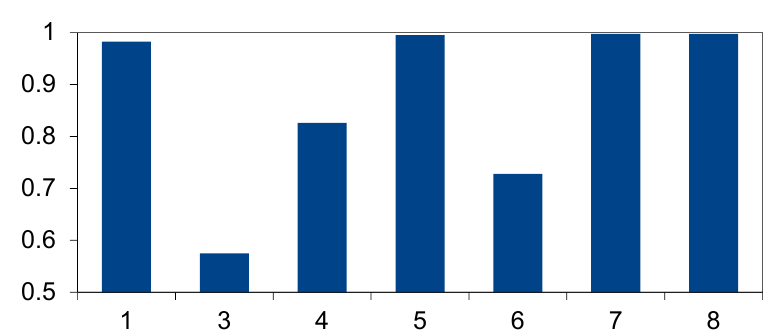
Figure 8. Results of the thermal treatment of EVA foil from different producers at 700 °C for 3 h.